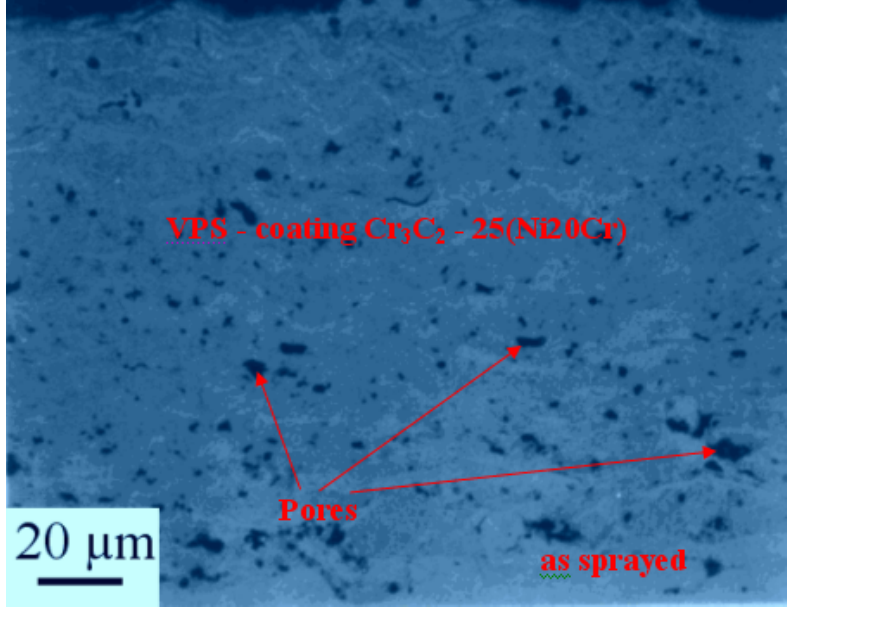
Рис . 2 – Микроструктура покрытия Cr 3 C 2 - 25 (Ni20Cr) в нанесенном состоянии